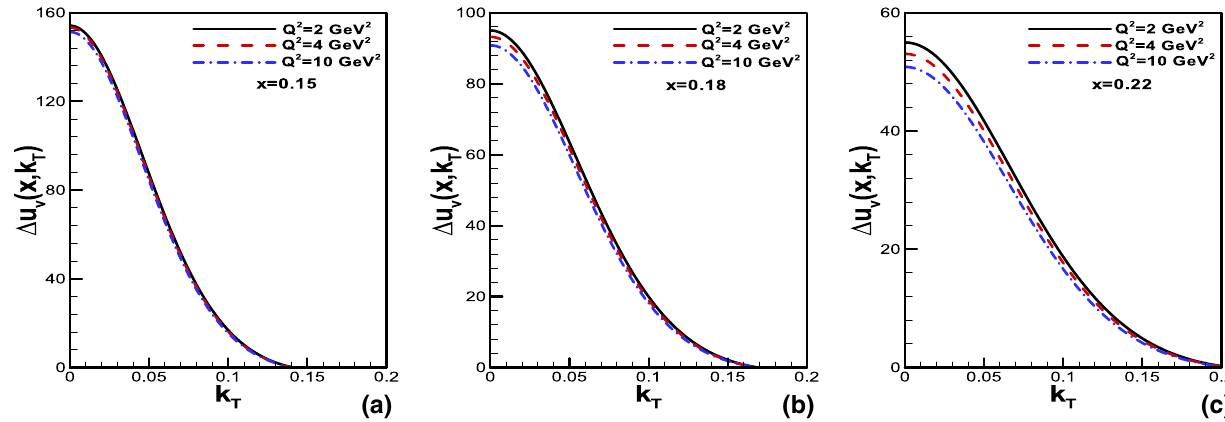
Fig. 14 The k T -distribution of polarized up valence quark at a x = 0 . 15, b x = 0 . 18 and c x = 0 . 22. The TMD polarized valence distributions are plotted at three values of Q 2